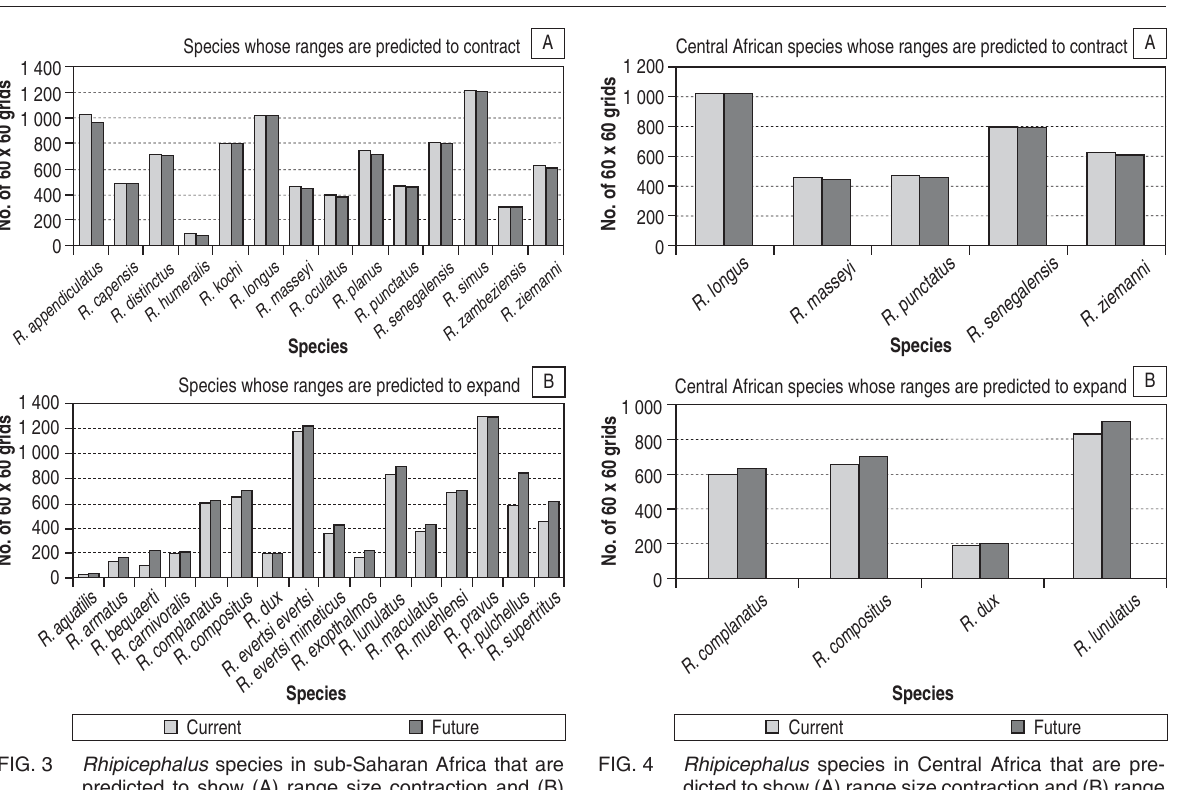
FIG. 4 Rhipicephalus species in Central Africa that are pre- dicted to show (A) range size contraction and (B) range size